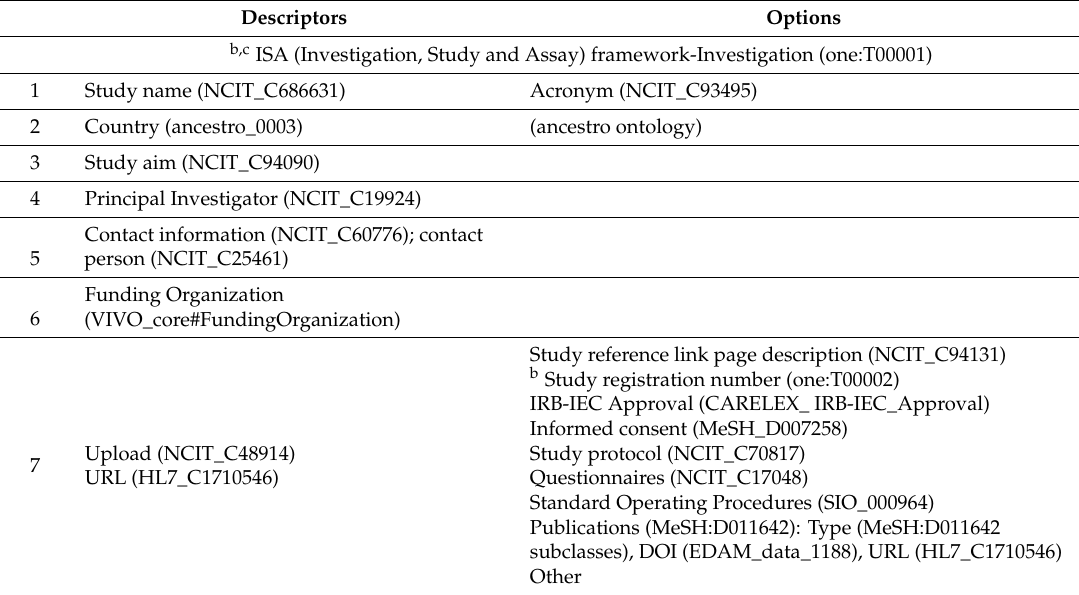
Table A8. Ontology view of minimal data requirement of observational